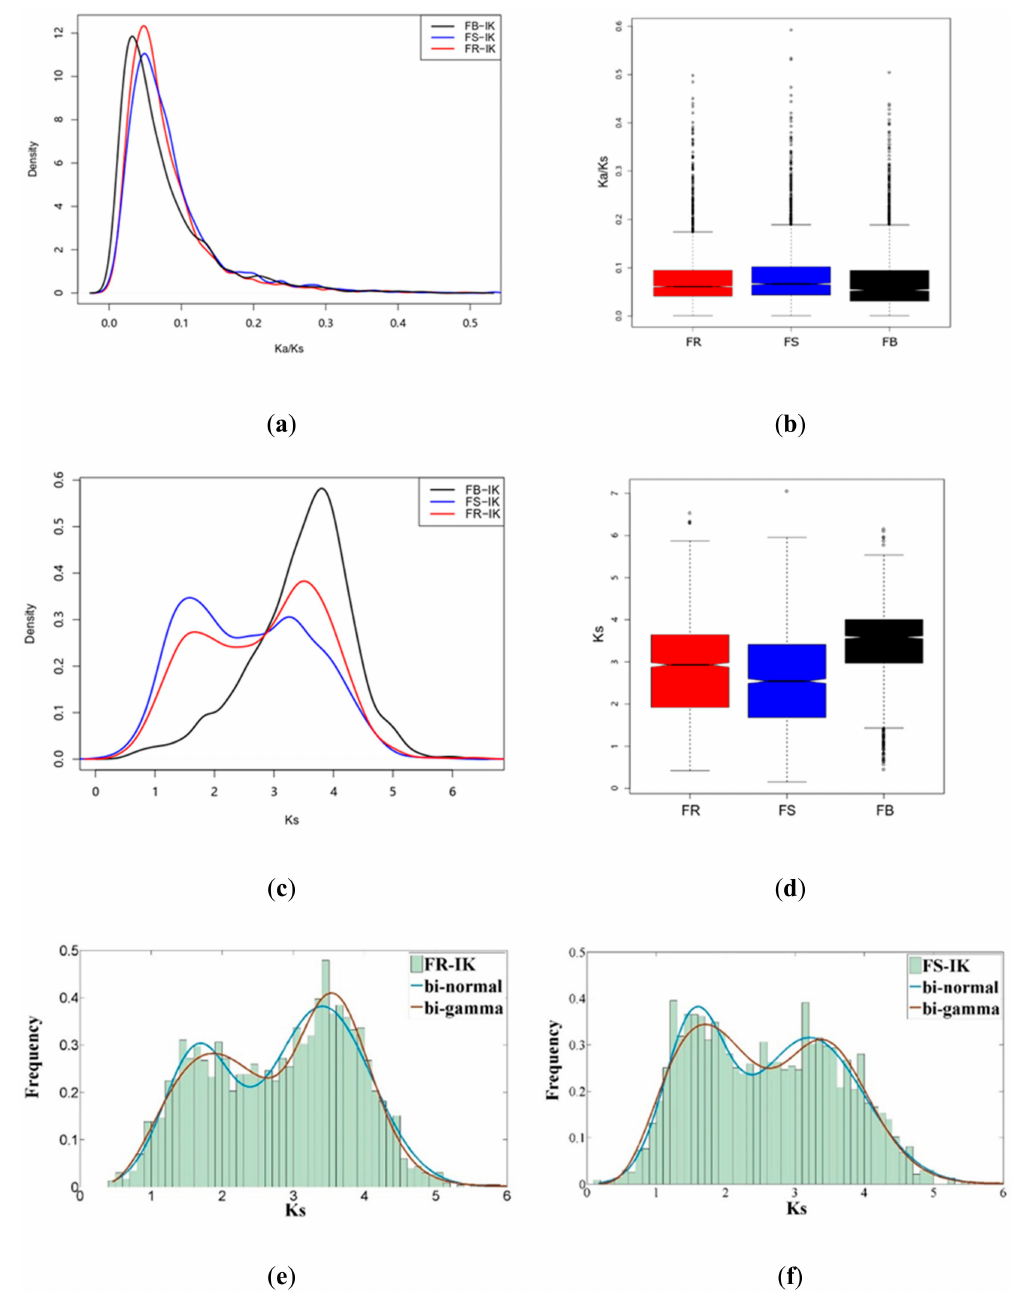
Figure 5. The comparison of ortholog sequence divergence between IK-1 T and its phylogenetic neighbors. ( a ) The distribution of Ka / Ks values of orthologous genes between IK-1 T and its phylogenetic neighbors. ( b ) The comparison of Ka / Ks values of orthologous genes between IK-1 T and its phylogenetic neighbors by boxplot. ( c ) The distribution of Ks values of orthologous genes between IK-1 T and its phylogenetic neighbors. ( d ) The comparison of Ks values of orthologous genes between IK-1 T and its phylogenetic neighbors by boxplot. ( e ) Fitting of Ks frequency of orthologous genes between IK-1 T and F. rivuli . ( f ) Fitting of Ks frequency of orthologous genes between IK-1 T and F. subsaxonicum . IK: F. akiainvivens IK-1 T , FB: F. beibuense F44-8, FS: F. subsaxonicum DSM 21790, FR: F. rivuli DSM